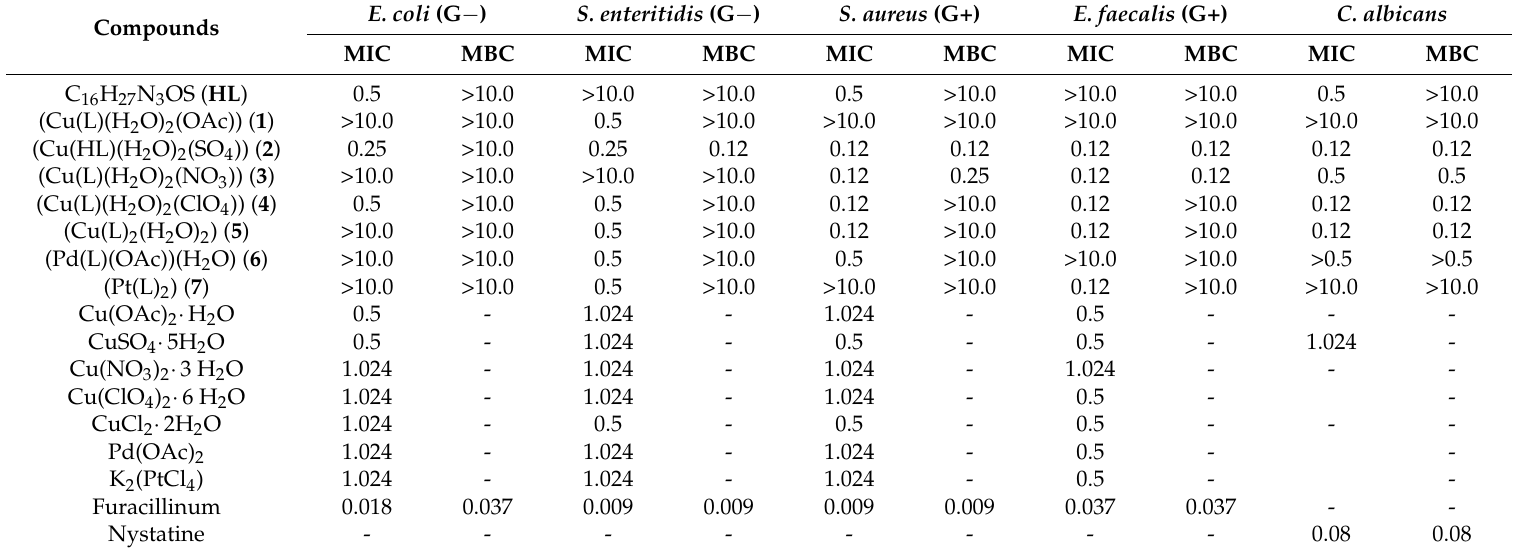
Table 3. Antibacterial and antifungal activities of ligand ( HL) and complexes 1 – 7 as MIC a /MBC b values (mg/mL).